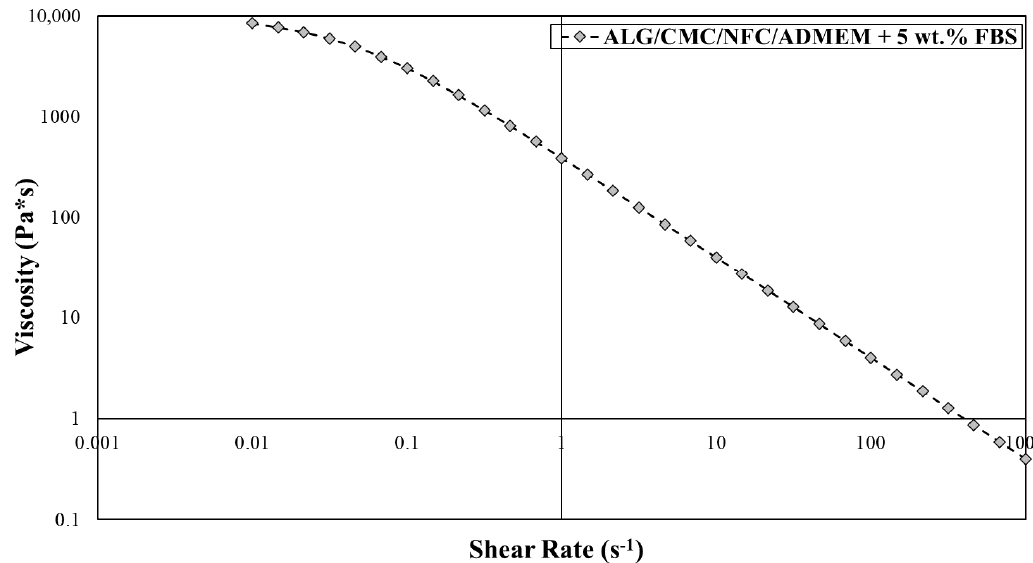
Figure 2. Viscosity measurements for alginate/carboxymethyl cellulose/nanofibrillated cellulose (ALG/CMC/NFC)-based bioink formulation using the Anton Paar Rheolab QC with cylinder measuring system CC27.